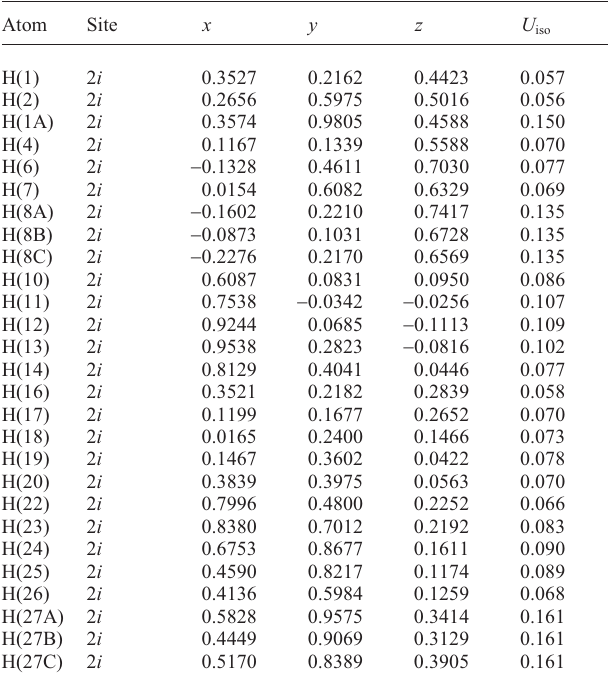
Table 1. Data collection and handling.